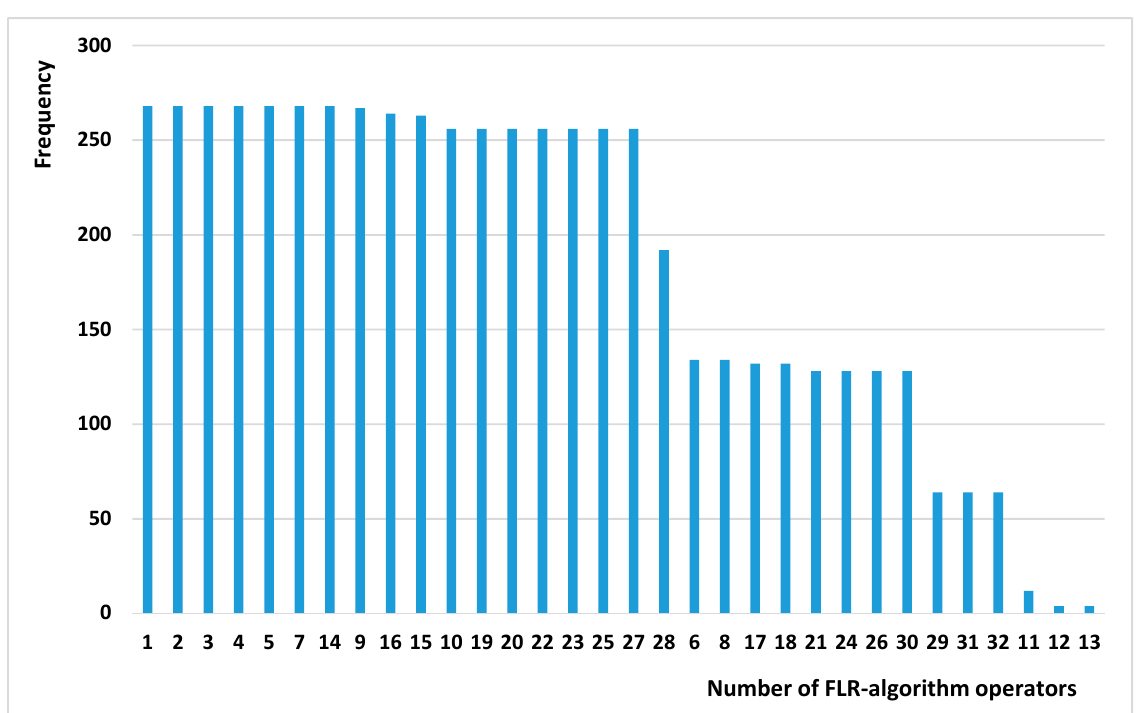
Figure 4. Frequency plot of the FLR technological operations in the FLR algorithm implementation.